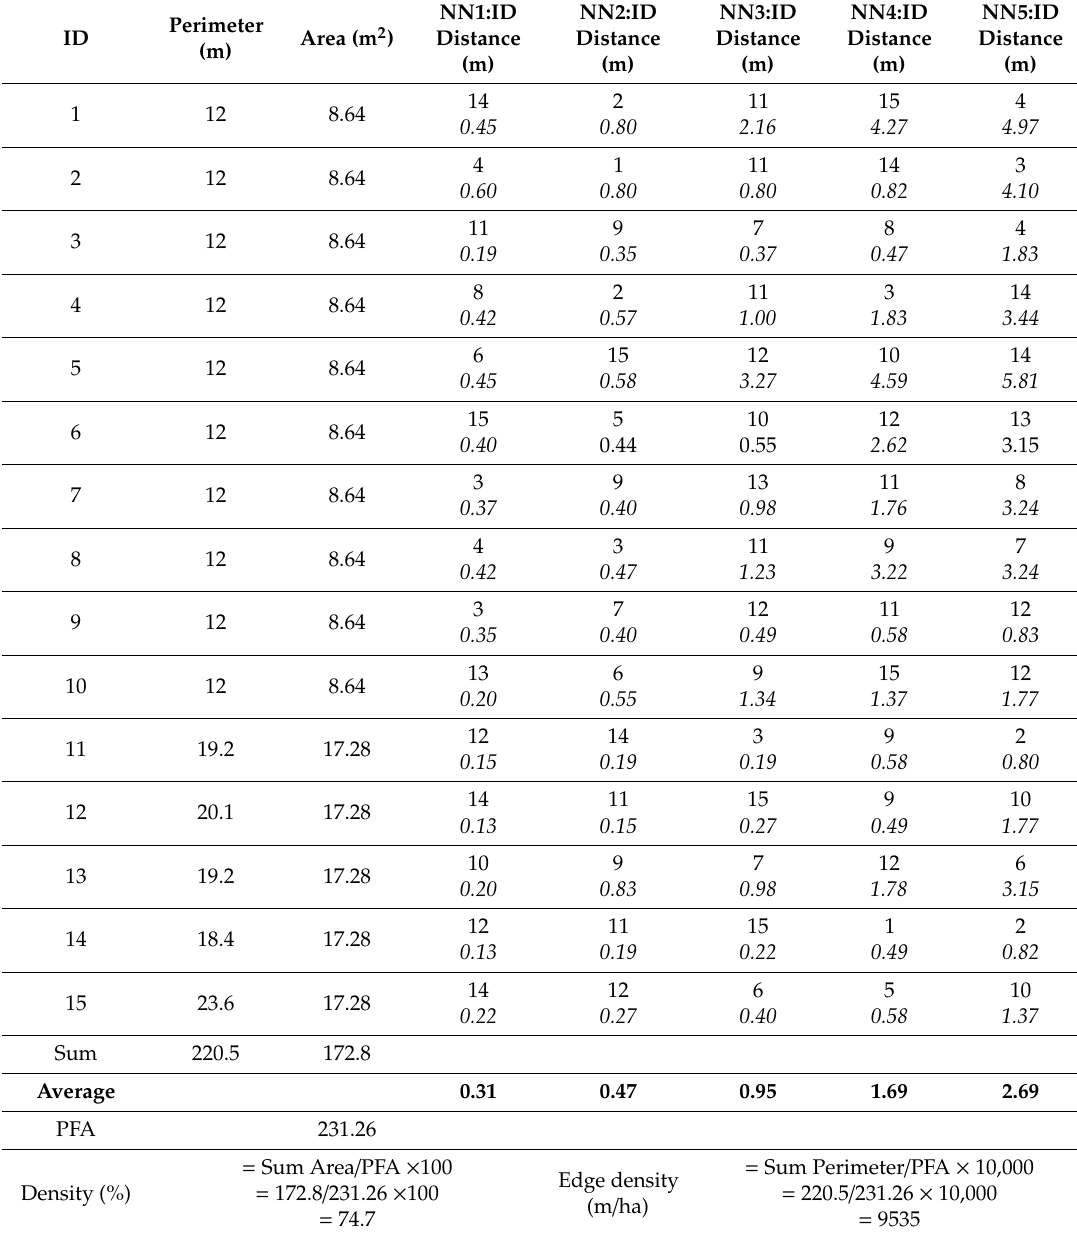
Table 2. Spatial metrics calculated for the settlement shown in Figure